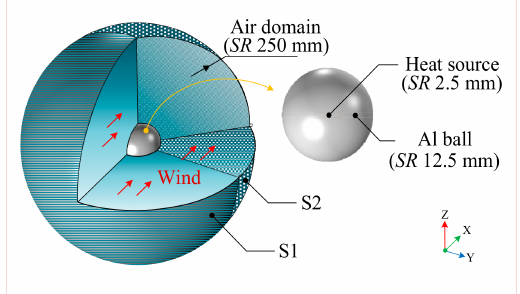
Figure 9. Geometry in FEM of Al